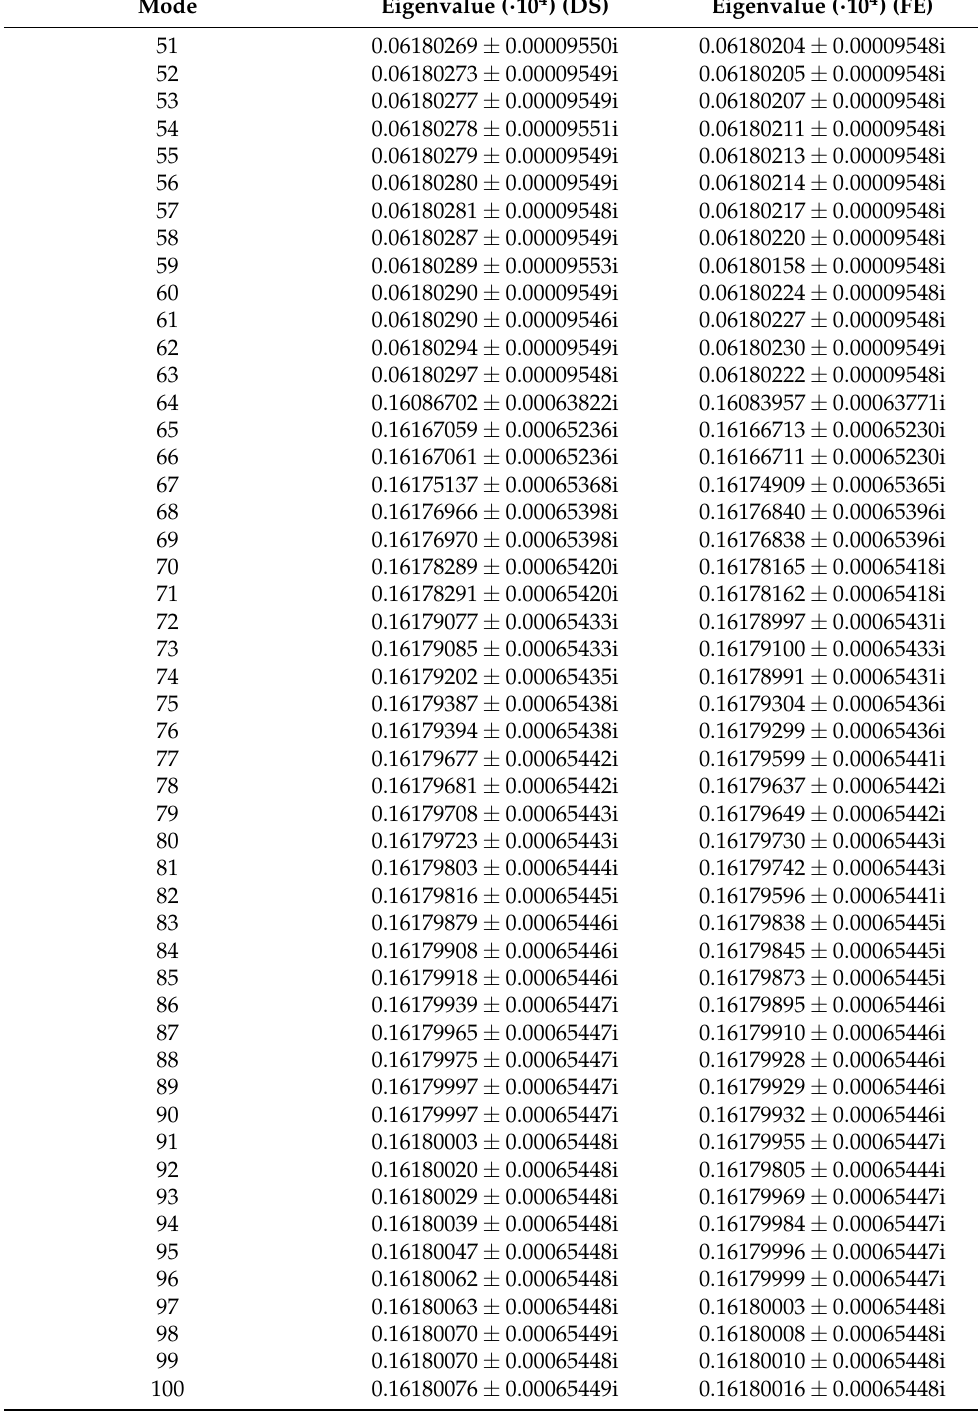
Table A2. Complex eigenvalues (from 51 to 100) of the LRMP in Figure 3 with 2-DOF resonators, computed by means of the proposed dynamic-stiffness approach (DS) and the FE method